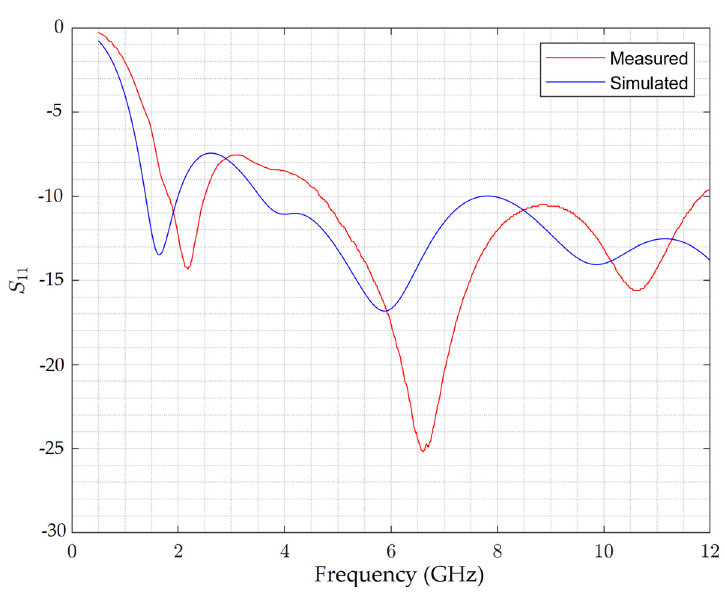
Figure 5. Comparison of simulated and measured return loss parameters.